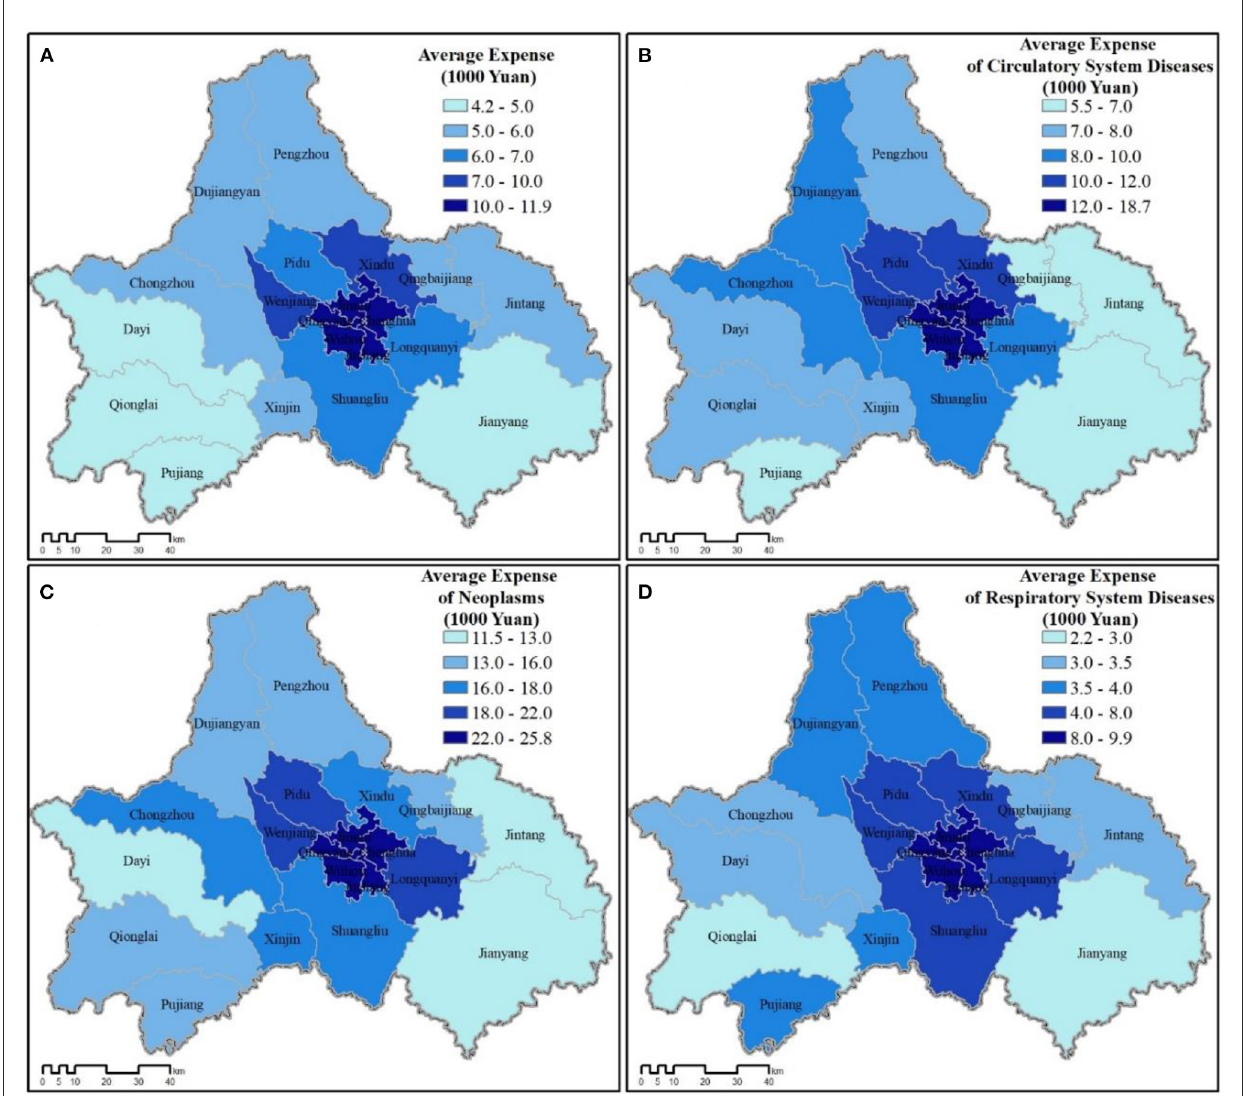
deviations and inpatient expenditures were insignificant (Table